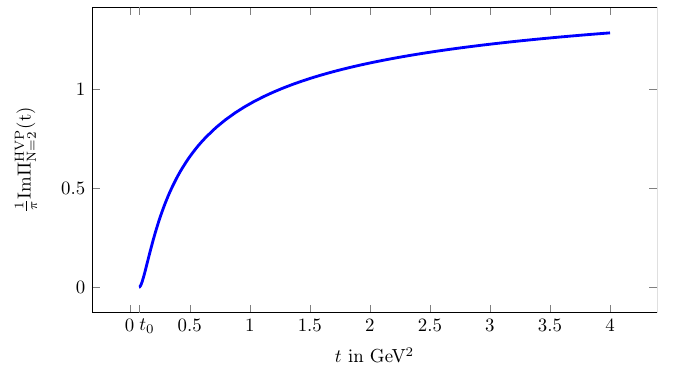
Figure 2 . Shape of the x -integrand in eq. (1.10) in α approximant: N = 2 , L = 1 .